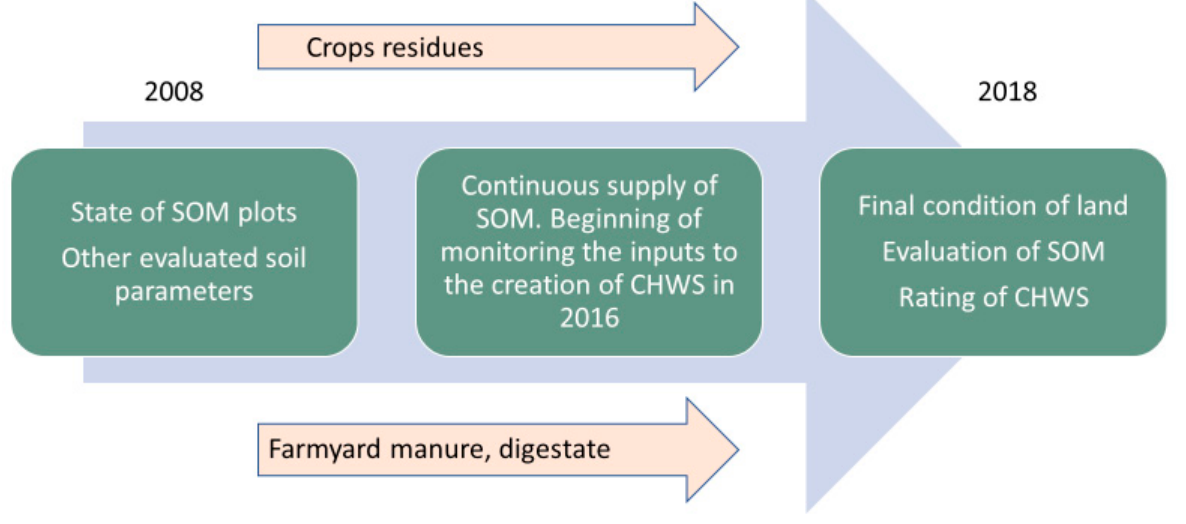
Figure 2. Principles of evaluation of SOM in fields.